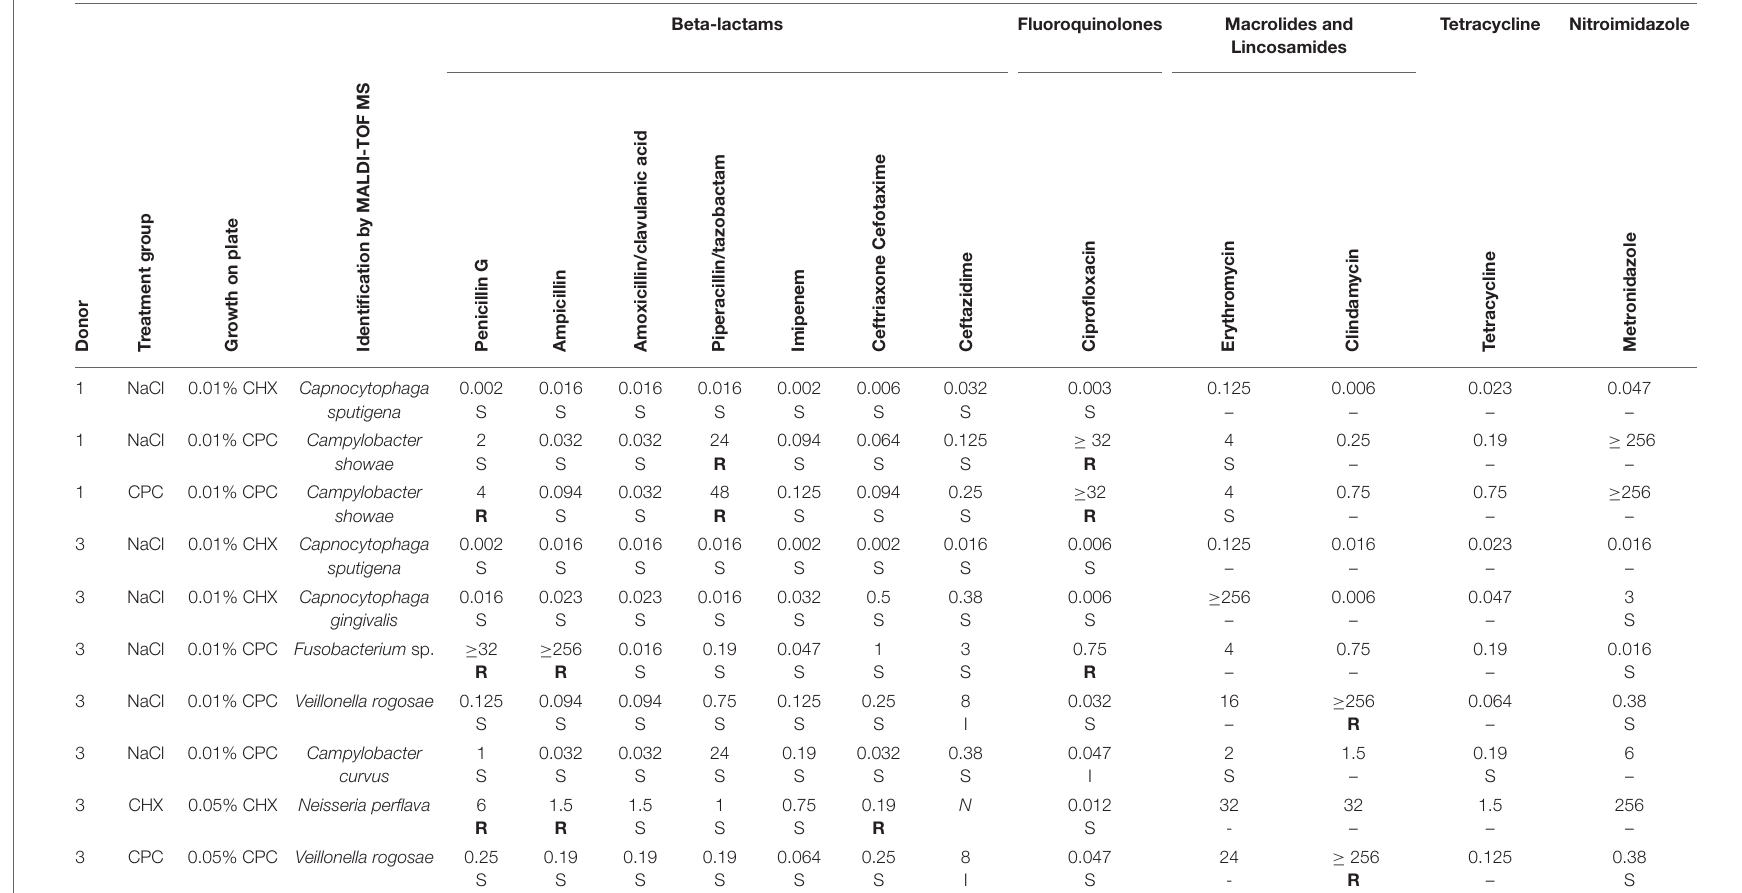
TABLE 1 | Antiseptic-resistant phenotypes isolated from the biofilms and evaluation of antibiotic